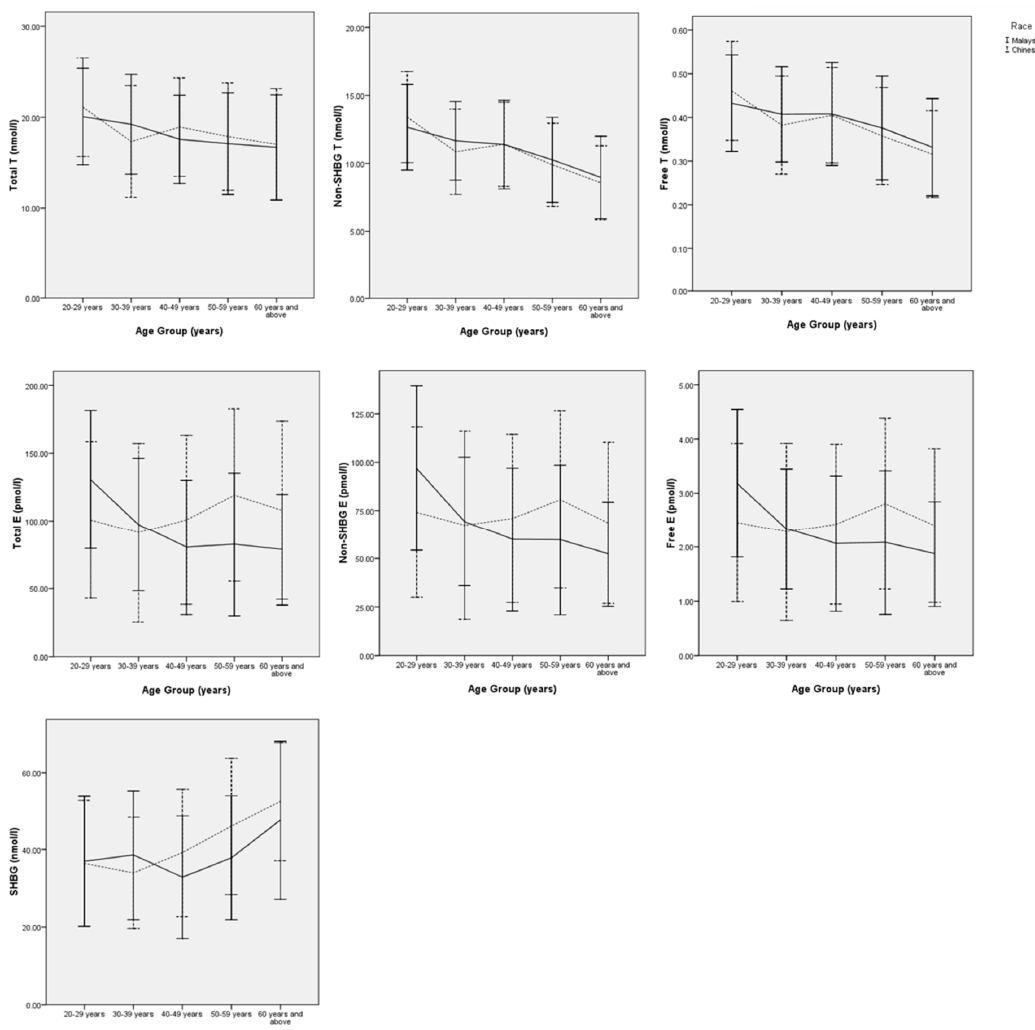
Figure 2. The age-trend of sex hormones between Chinese and Malay men in Malaysia [62].